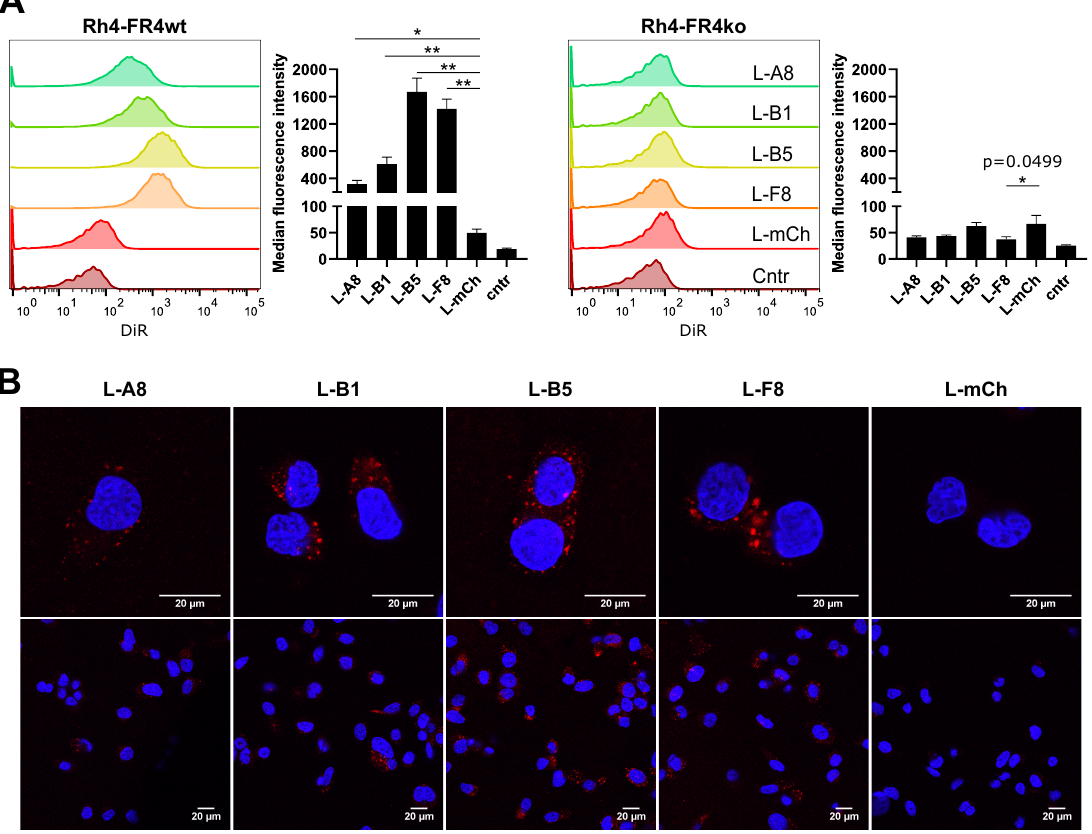
Figure 5. In vitro binding validation of FGFR4 targeting liposomes. ( A ). Liposomes decorated with FGFR4 targeting sdAb A8, B1, B5 and F8 or mCh (negative control) were tested for their binding selectivity to cell surface FGFR4 by flow cytometry. Adherent cells were incubated for 2 h with 0.5 mM total lipid concentration at 37 ◦ C and 5% CO2. Histograms show the single-cell living population of liposomes binding to Rh4-FR4wt versus Rh4-FR4ko cells. Non-treated cells represent the control populations. Median fluorescence intensities (MFI) are shown. Statistics: paired t -test, n = 3 independent experiments, mean + SD, * p ≤ 0.05, ** p ≤ 0.01. ( B ) Confocal microscopy analysis of Rh4-FR4wt cells incubated for 2 h at 37 ◦ C and 5% CO 2 with sdAb coated fluorescent liposomes. The total lipid concentration was 3 mM. Cells were washed, fixed and mounted with DAPI containing medium. Internalization was visible only in Rh4-FR4wt cells incubated with FGFR4-targeted